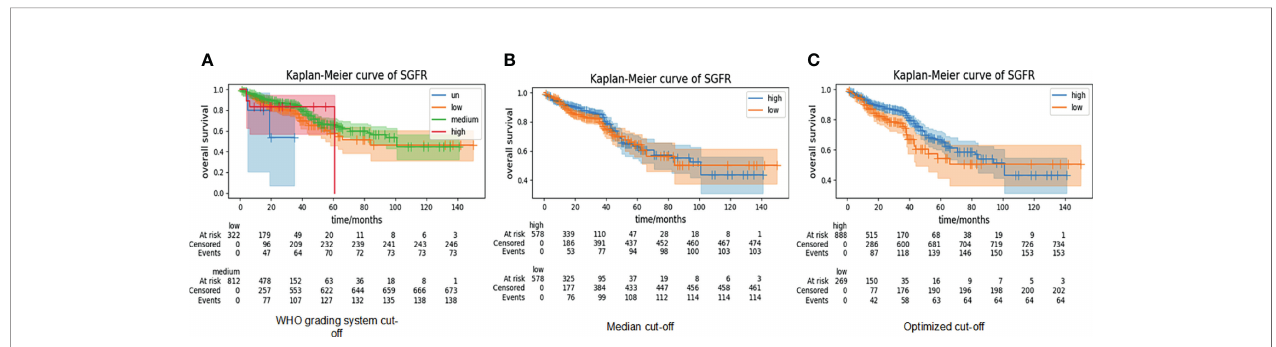
FIGURE 4 | Kaplan – Meier curves of semi-quantitative gland formation ratio (SGFR) with cutoff method of WHO, median, and optimized. According to WHO ’ s grading system, the WSIs can be grouped into high differentiation (high, SGFR > 0.95), medium differentiation (medium, 0.5 < SGFR < 0.95), low differentiation (low, 0.05 < SGFR < 0.50), and un-differentiation (un, SGFR < 0.05), and the related Kaplan – Meier curves are shown in panel (A, B) KAPLAN – Meier curves of WSIs with SGFR higher than median (high) and SGFR lower than median (low). (C) Kaplan – Meier curves of WSIs with SGFR higher than optimized cutoff point (high) and SGFR lower than optimized cutoff point (low). WSIs, whole-slide images.